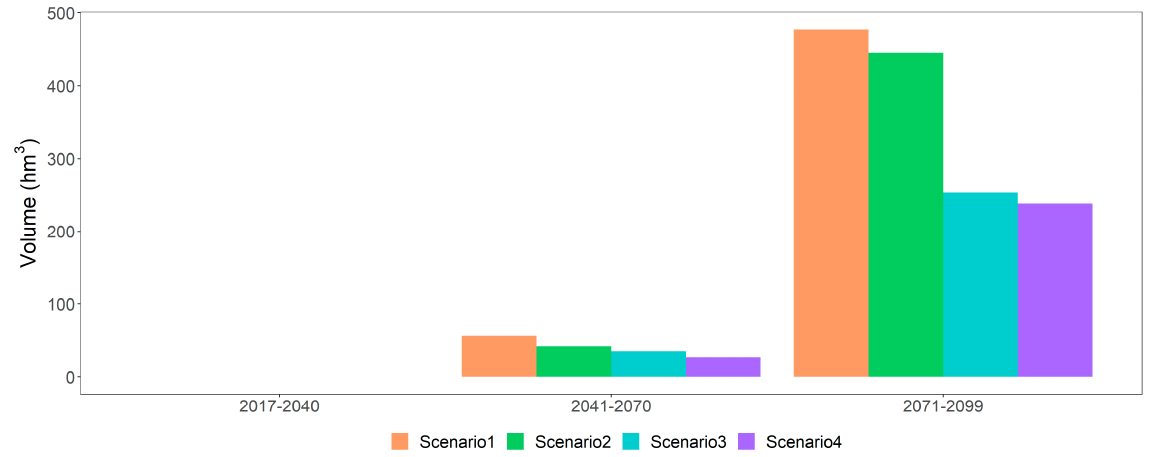
Figure 15. Annual unmet demand with socio-economic changes in Scenarios 1, 2, 3, and 4.